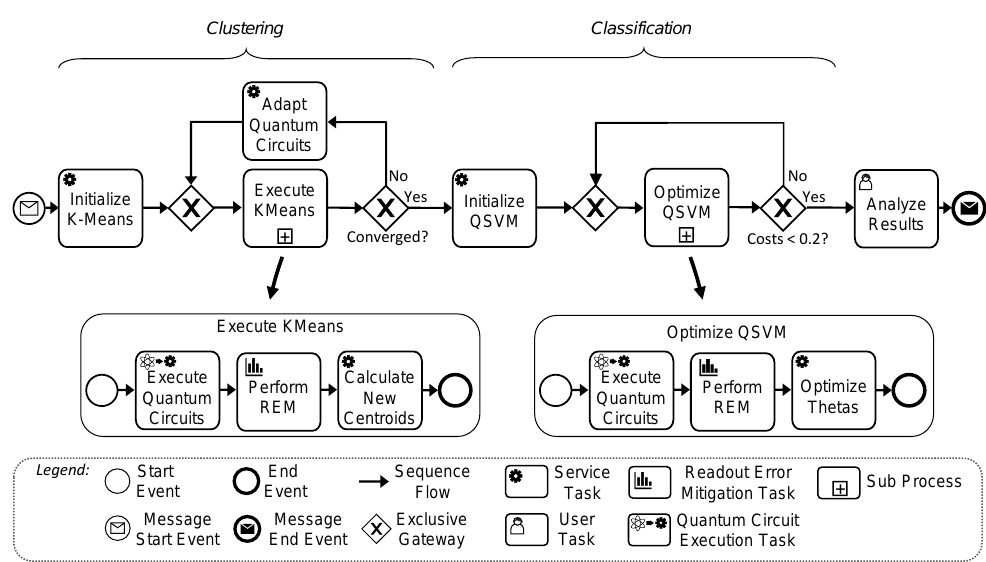
Figure 8. Exemplary workflow model from the quantum humanities